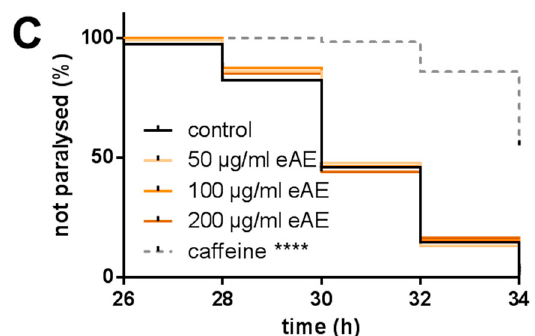
Figure 2. Effects of eAE on life span and resistance against thermal and amyloid- β -stress. ( A ) Modulation of life span: Wild type L4 larvae were incubated with different concentrations of eAE or DMSO (vehicle, 0.4%) at 25 °C. On five days a week, medium was exchanged and survival of the nematodes was tested via touch-provoked movement. Kaplan-Meier statistics were used for the comparison of the survival curves, n = 3 (each 40 individuals per group), Log Rank (Mantel-Cox) test, * p ≤ 0.05, ** p ≤ 0.01, *** p ≤ 0.001; ( B ) Thermal stress resistance: Wild type L4 larvae were treated with different concentrations of eAE or with DMSO (vehicle, 0.4%) for 24 h at 20 °C, and then transferred individually into the wells of a 384-well plate containing 1 µM SYTOX ® Green. The increase in fluorescence was measured at 37 °C. The graph shows the percentage of viable nematodes. Kaplan-Meier statistics were used for the comparison of the survival curves, n = 3 (each 16 individuals per group), Log Rank (Mantel-Cox) test, *** p ≤ 0.001; ( C ) Toxicity of A β : Transgenic nematodes of the strain CL4176 were incubated as eggs with different concentrations of eAE, DMSO (vehicle, 0.4%) or caffeine as a positive control at 16 °C. L3 larvae were transferred on agar plates containing a lawn of E. coli var. OP50 and kept at 25 °C. After 26, 28, 30, 32, and 34 h, nematodes were analyzed for occurrence of paralysis. Kaplan-Meier statistics were used for the comparison of the survival curves, n = 3 (each 40 individuals per group), Log Rank (Mantel-Cox) test, **** p ≤ 0.0001. Calculated data for the experiments are shown in Supplementary Tables S1, S2, and S4.